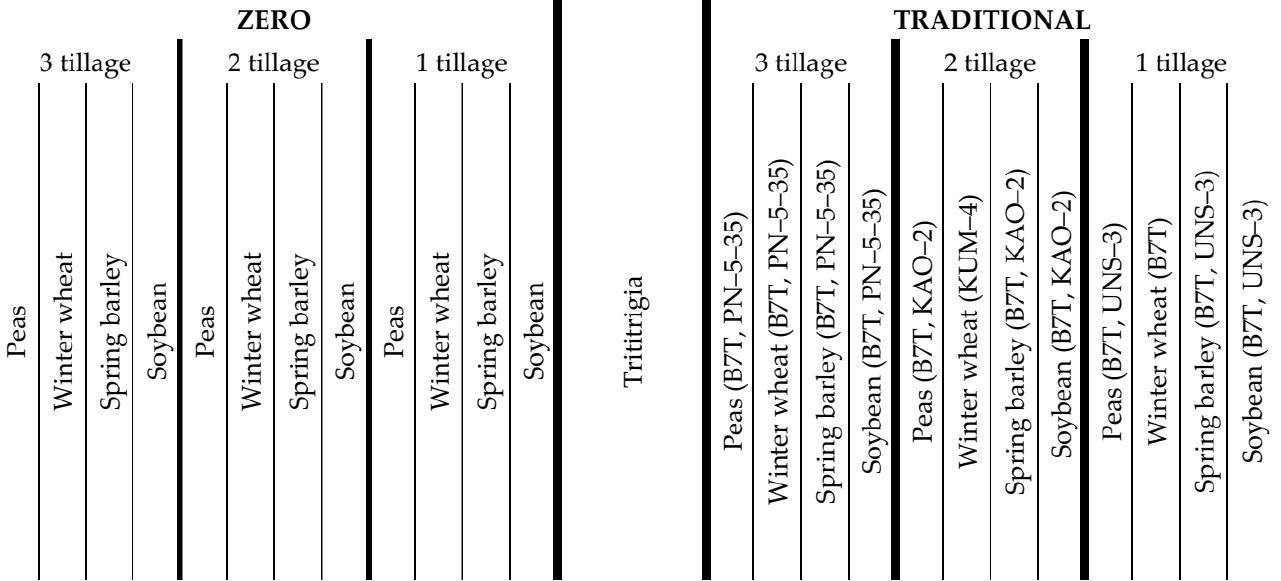
Table 1. Indicators of the soil fertility in the experimental area. Bulk Density (g cm − 3 )